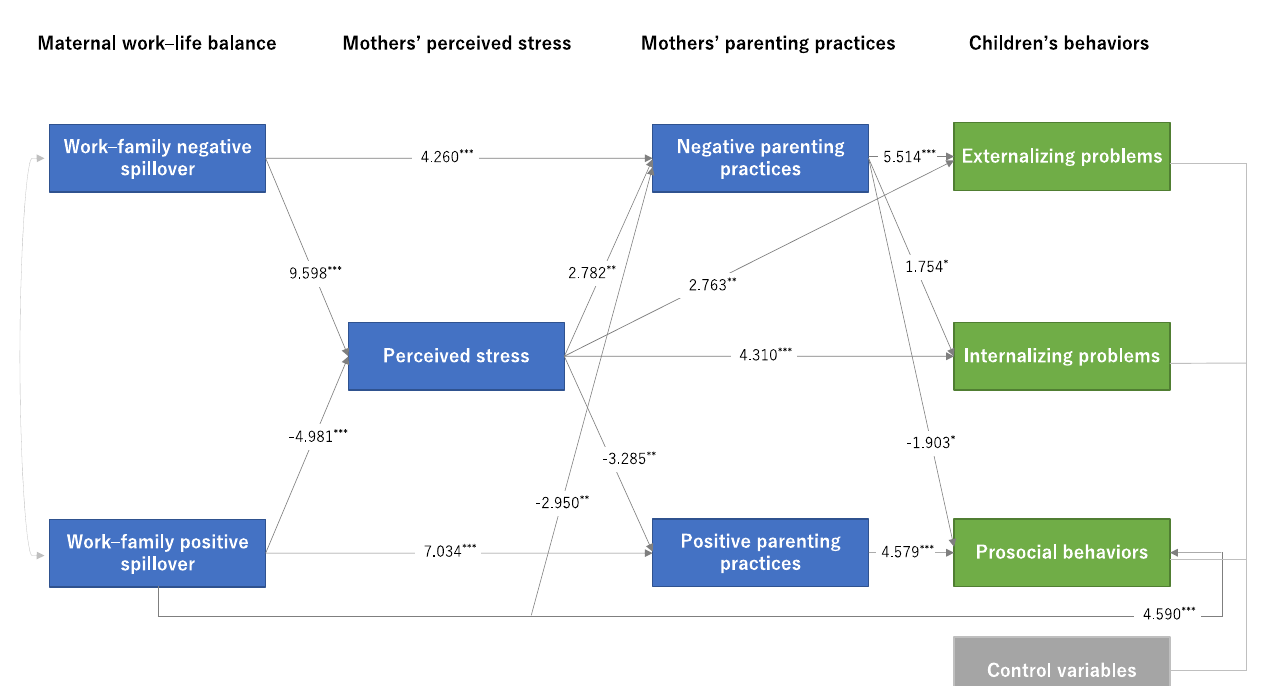
Figure 1. Path of maternal work–life balance, perceived stress, parenting practices, and children’s behaviors. Note: This model includes paths that are statistically significant in the hypothesized model. Control variables include children’s gender, family structure, family income, and parental educational attainment. Model fit statistics: χ 2 (29) = 45.04; CFI = 0.98; IFI = 0.98; RMSEA = 0.03. * p < 0.05; ** p < 0. 01; *** p < 0.001.